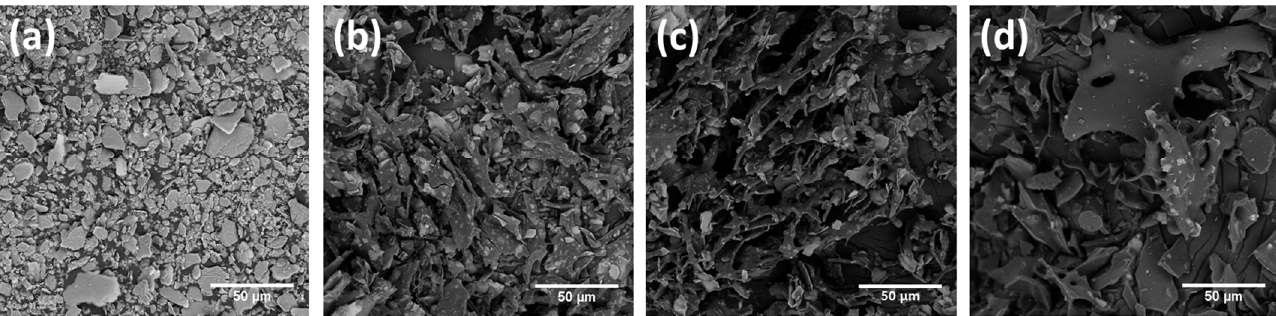
Figure 3. Scanning electron microscopy images of ( a ) illite, ( b ) P-lite1, ( c ) P-lite2, and ( d ) P-lite3 MPs. P-lite1, P-lite2, and P-lite3 MPs were prepared using a weight ratio of PVP to illite of 1:5, 1:10, and 1:20, respectively. PVP, polyvinylpyrrolidone; P-lite MPs, PVP-stabilized illite